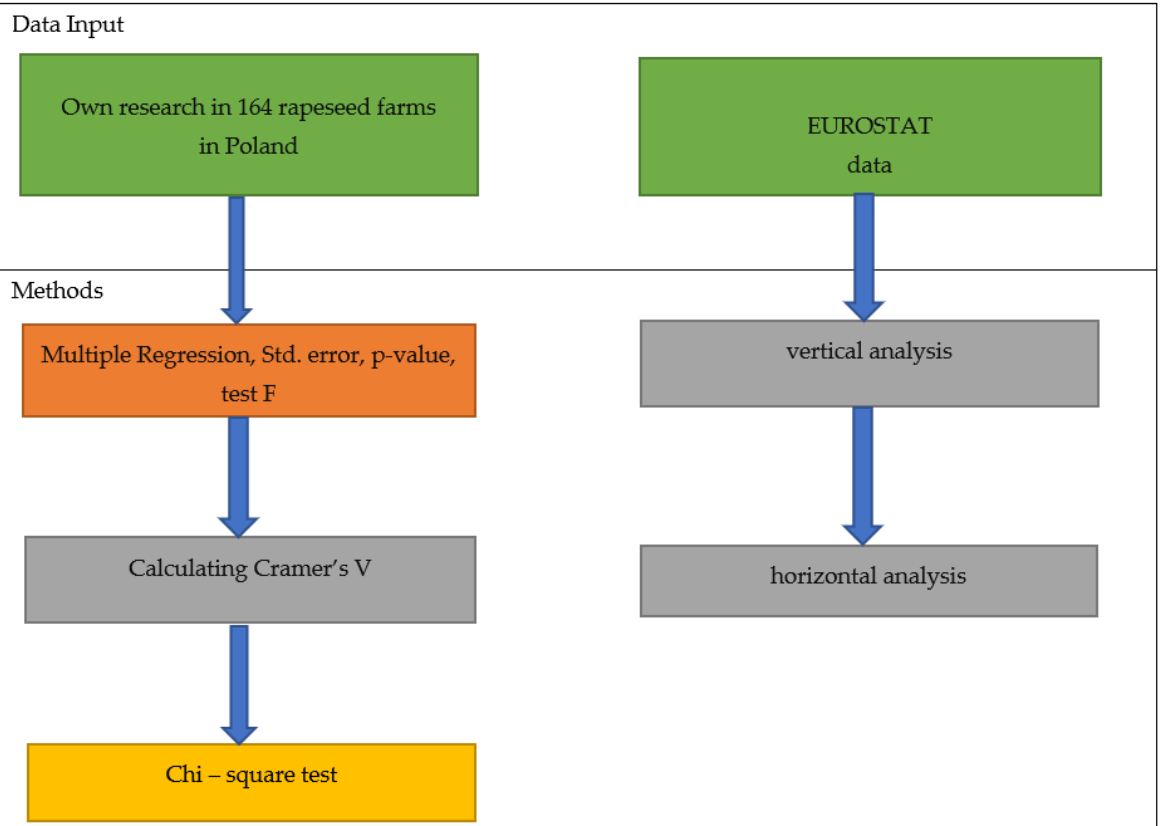
Figure 2. Overview of the methods. Details can be found in the text. Source: own study.